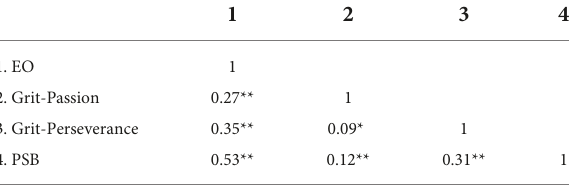
TABLE 2 Bivariate correlation matrix (Spearman’s rho) for the study